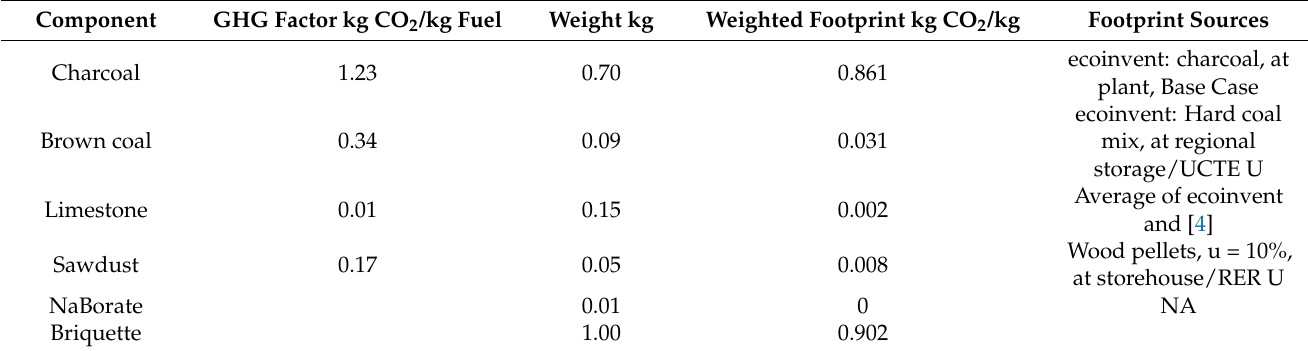
Table 2. Pre-combustion footprint of Kingsford charcoal briquettes.